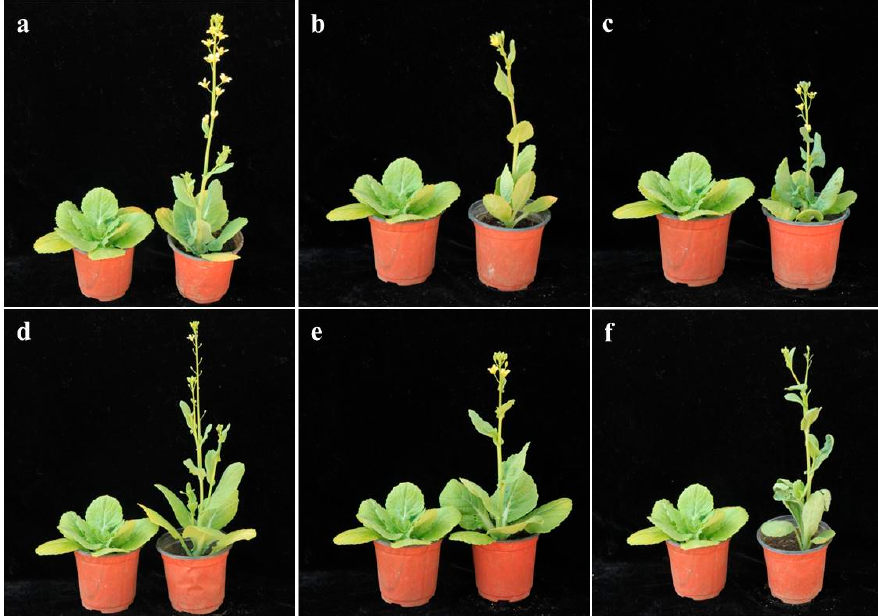
Figure 9. Six bolting mutants. ( a – f ) The wild-type ‘FT’ plants (left) and early bolting mutants (right). The frequency of fertility mutations was 0.72%, including male-sterile mutant (Figure 10) and female-sterile mutant (Figure 11). The stamens of male-sterile mutants completely degenerated without pollen. The female-sterile mutants showed pistil abortion and smaller floral organs. Figure 10. Five male-sterile mutants. ( a ) wild-type ‘FT’ plants; ( b – f ) male-sterile mutants. The red arrow points to the stamens.